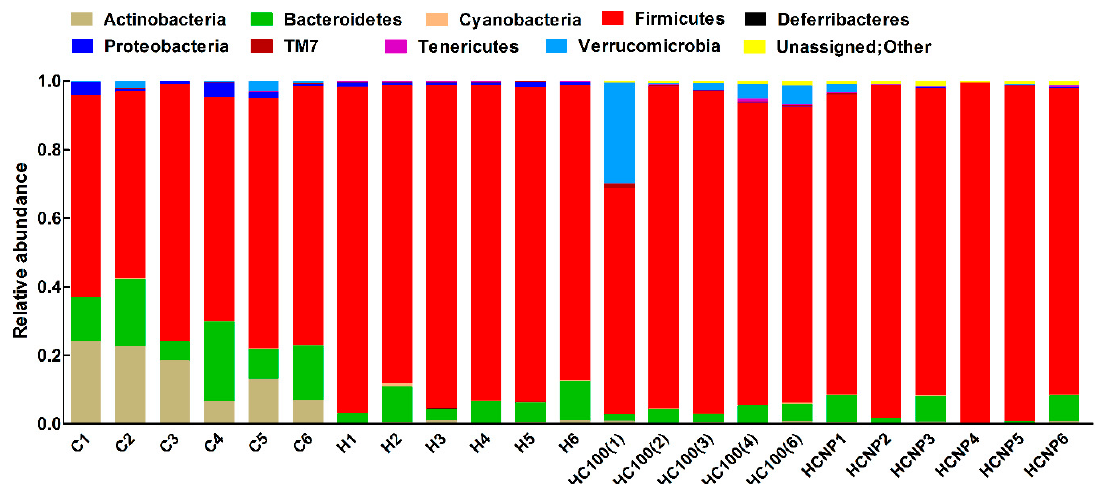
Figure 6. Effects of curcumin on gut microbiota at phylum level. C, corn starch diet-fed rats; H, high-carbohydrate, high-fat diet-fed rats; HC100, high-carbohydrate, high-fat diet-fed rats given 100 mg/kg/day curcumin; HCNP, high-carbohydrate, high-fat diet-fed rats given 5 mg/kg/day curcumin nanoparticles.